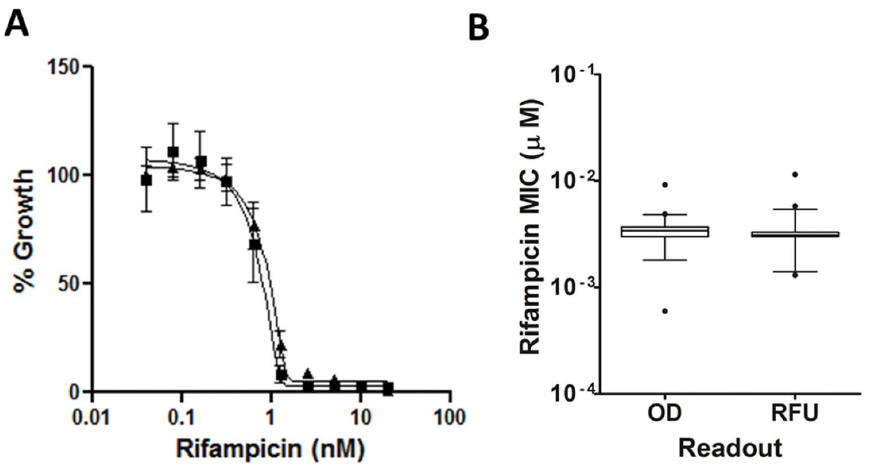
Figure 5. Assay reproducibility. A Dose response curve reproducibility for rifampicin. Results are the average of 8 independent dose response curves generated from the fluorescence + / 2 standard deviation. The MIC curves were generated using the Gompertz model B MIC reproducibility for rifampicin. MICs were calculated for rifampicin over a period of 12 months using fluorescence or OD. Results are for 337 independent rifampicin dose response curves are shown in a box and whiskers plot. MIC values that are outside the 99 percentile are indicated as outliers.